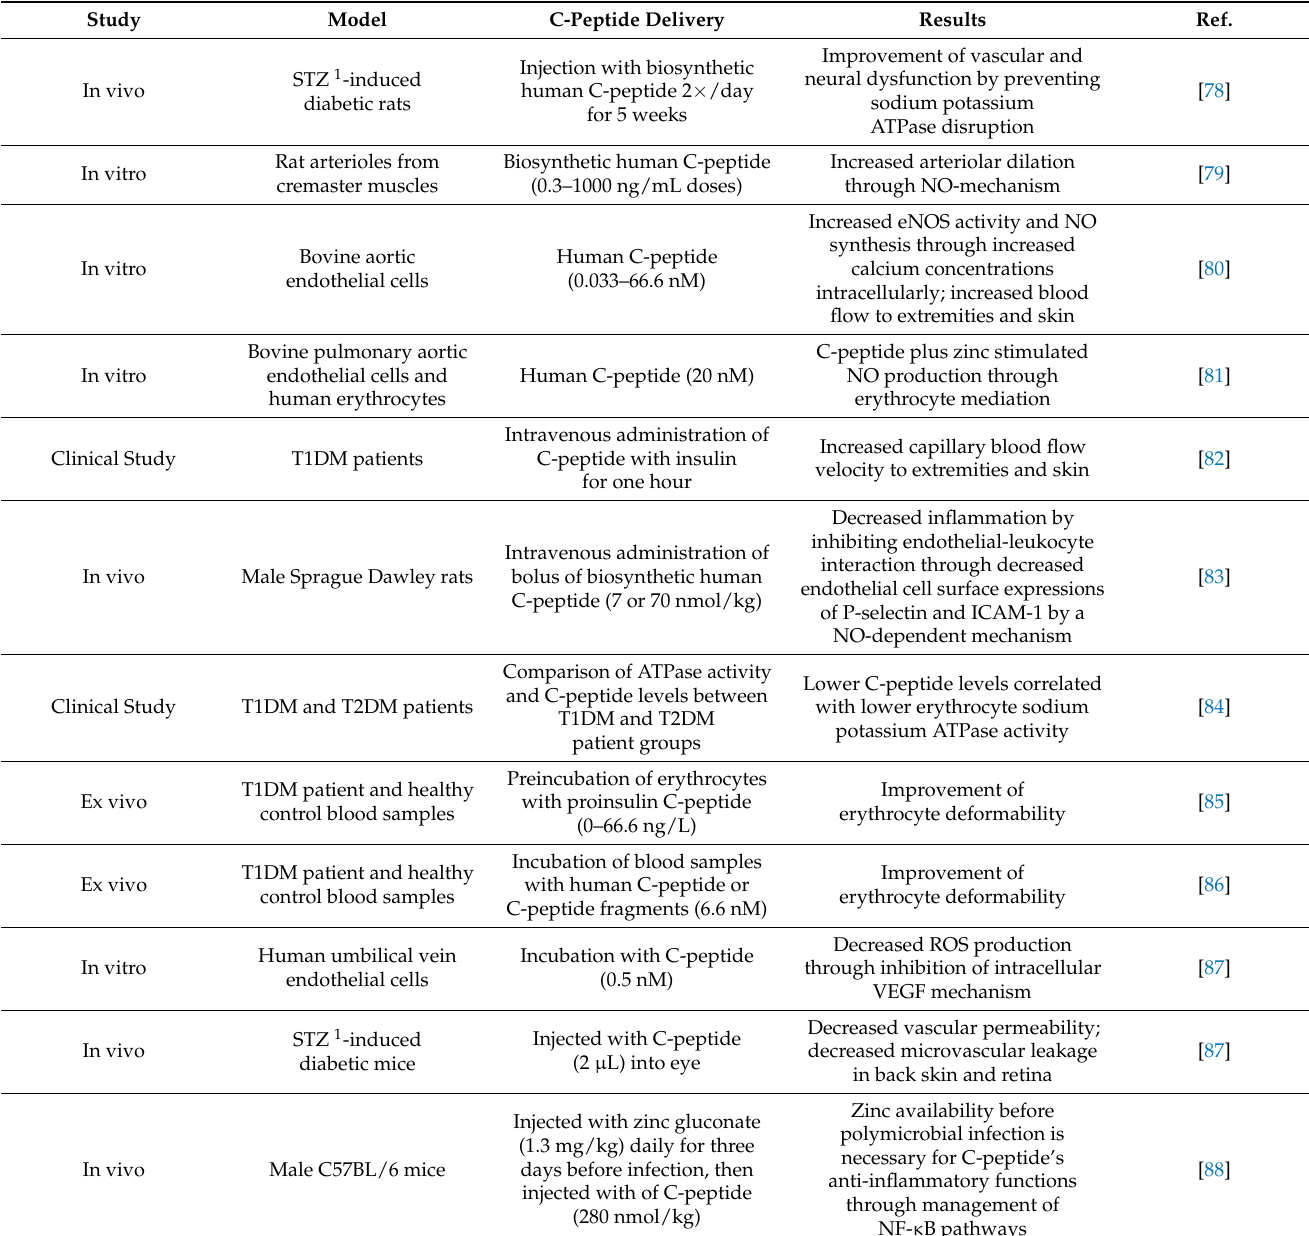
Table 1. Summary of C-Peptide Therapy